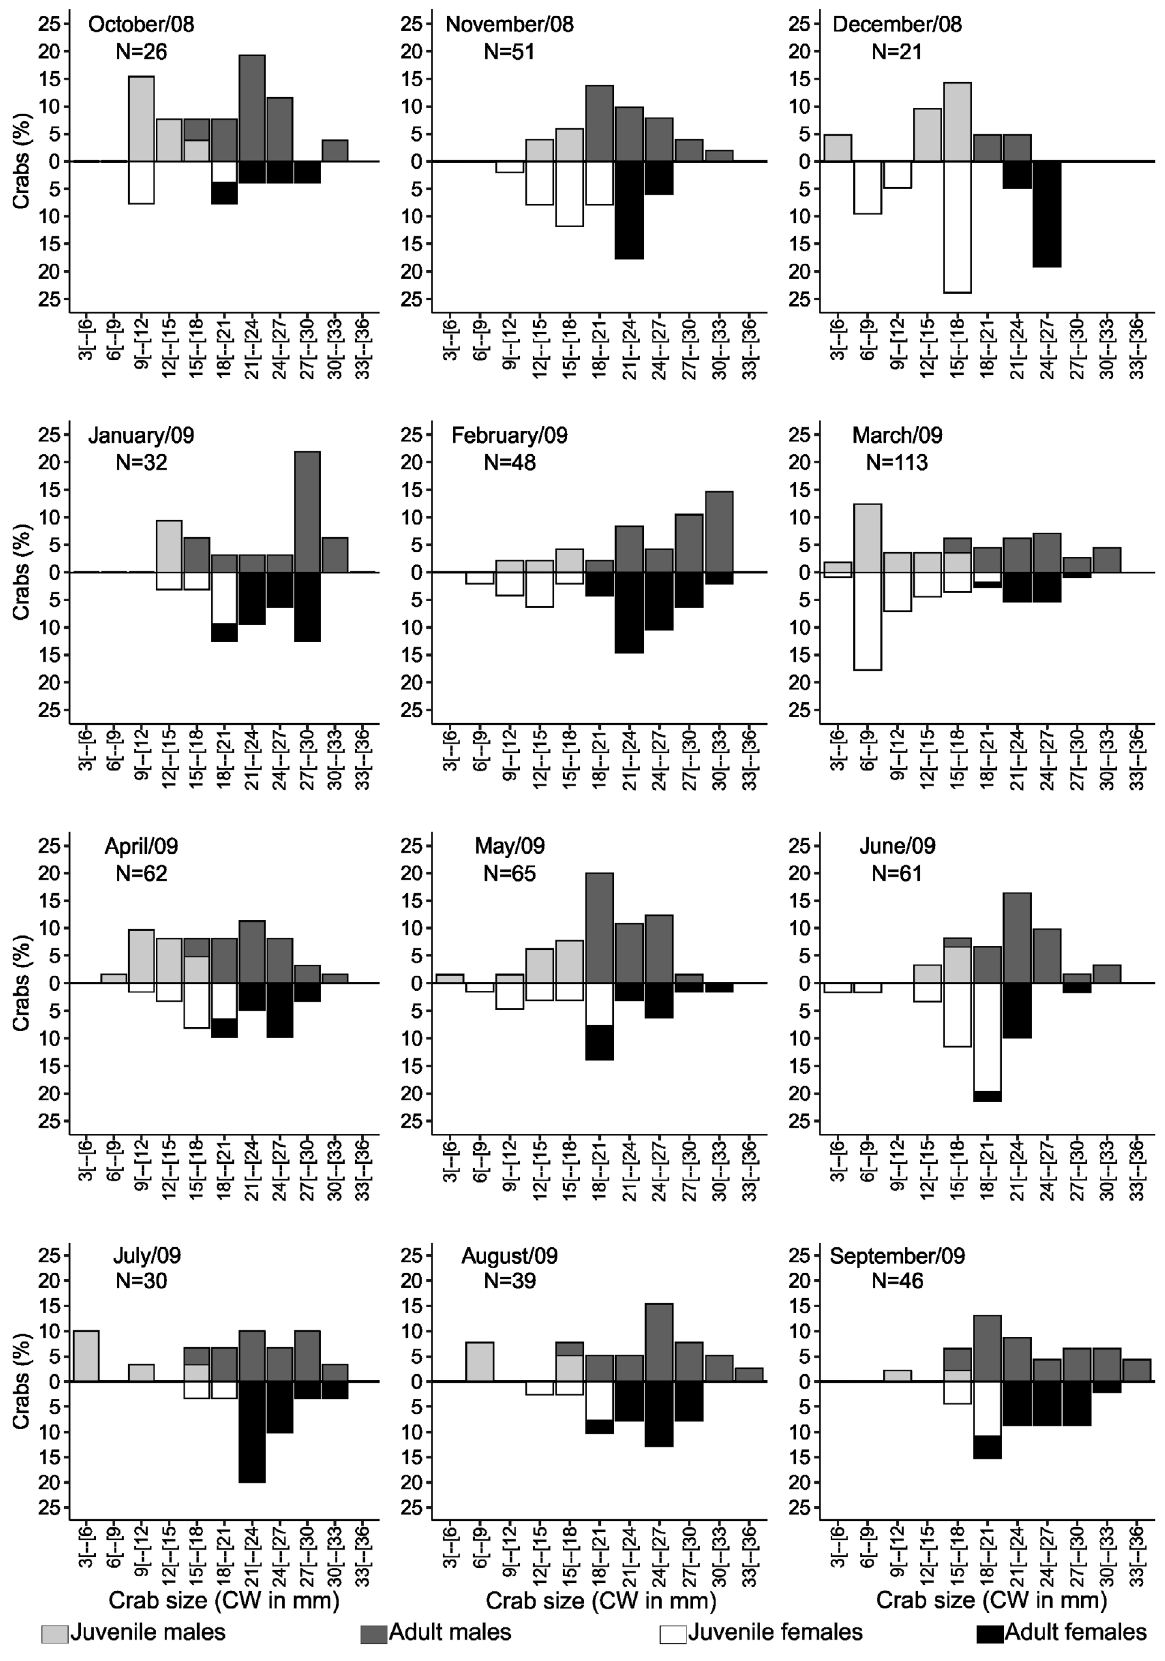
Figure 3. Frequency of juveniles, adult males, and adult females of Uca maracoani by crab size and